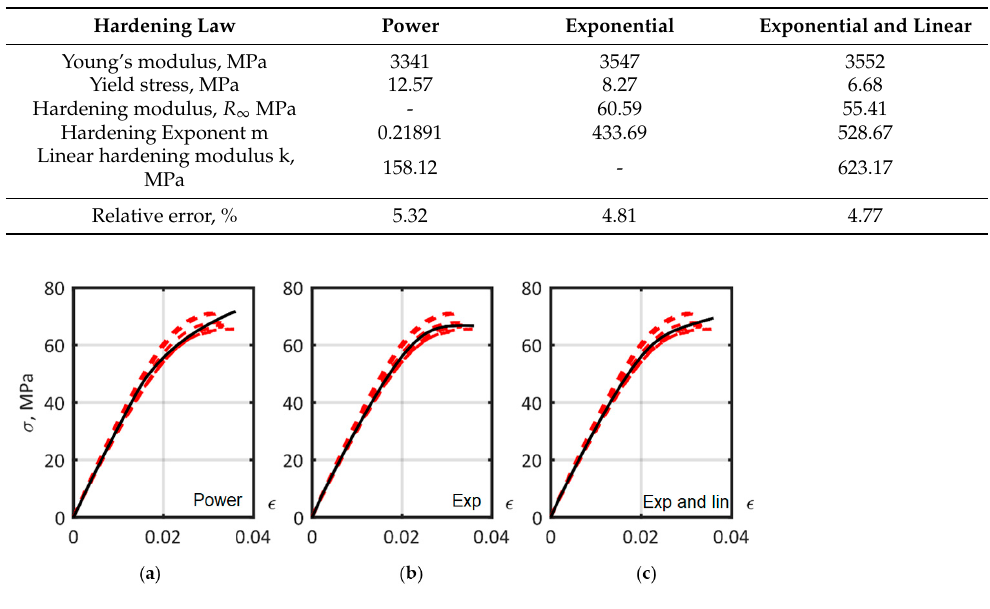
Figure 14. The approximation of PA6 matrix ISO 527-2 tension curves, dashed lines—experiment, solid lines—model, with hardening laws: ( a ) power; ( b ) exponential; ( c ) exponential and linear. The solid lines show the optimized curves. Dashed lines are the experimental data.